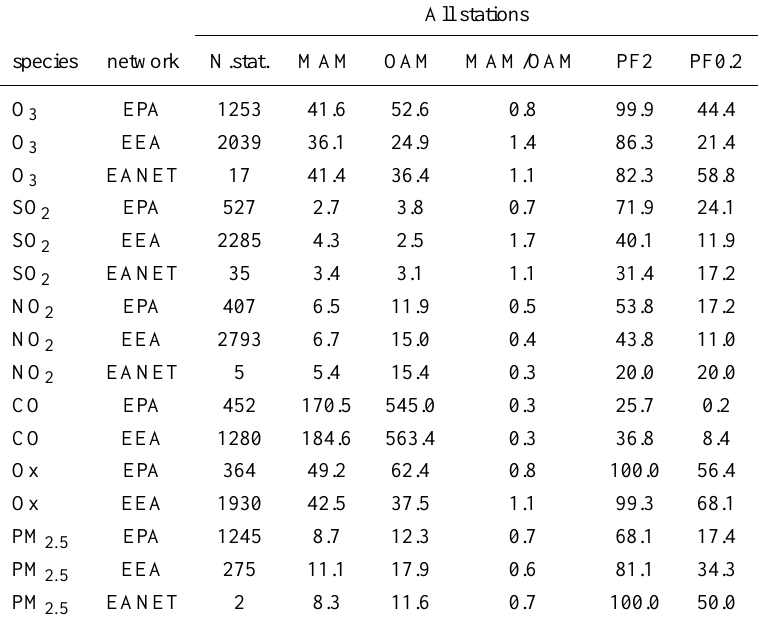
Table 2. Summary of the comparison of model data with observations. N.stat. is the number of locations/stations used in the comparison. OAM and MAM are the arithmetic mean of the observations and of the model, respectively. O 3 , SO 2 , NO 2 , CO and O x are in nmol mol − 1 , while PM 2 . 5 is in µg m − 3 . The model has been sampled at the locations of the observations, and the calculations are based on annual averages. PF2 is the percentage of model results within a factor of two of the observations and PF0.2 is the percentage of model results within 20% of the observations. O x represents NO 2 + O 3